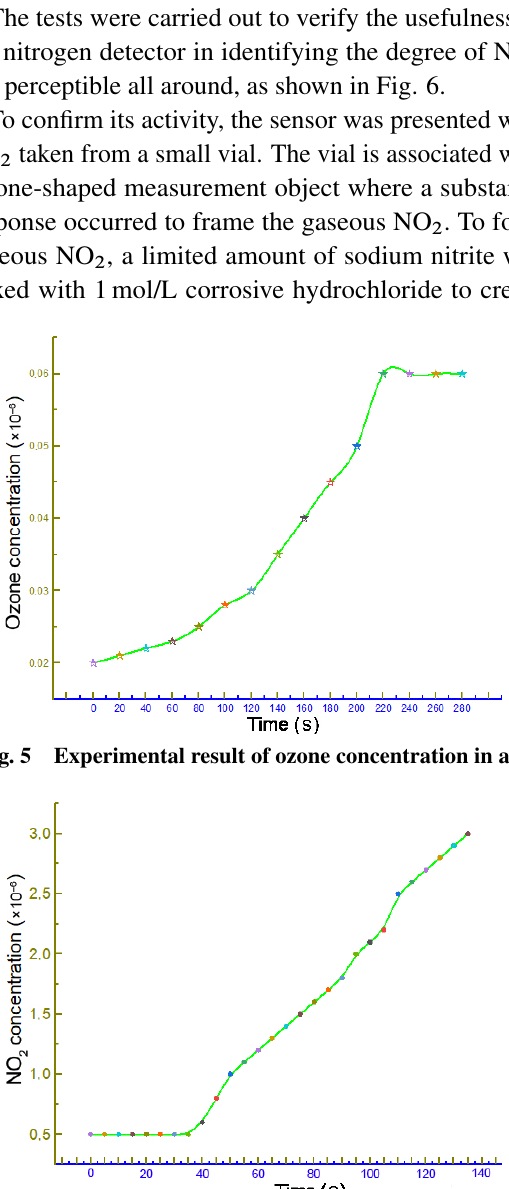
Fig. 6 Experimental result of NO 2 concentration in